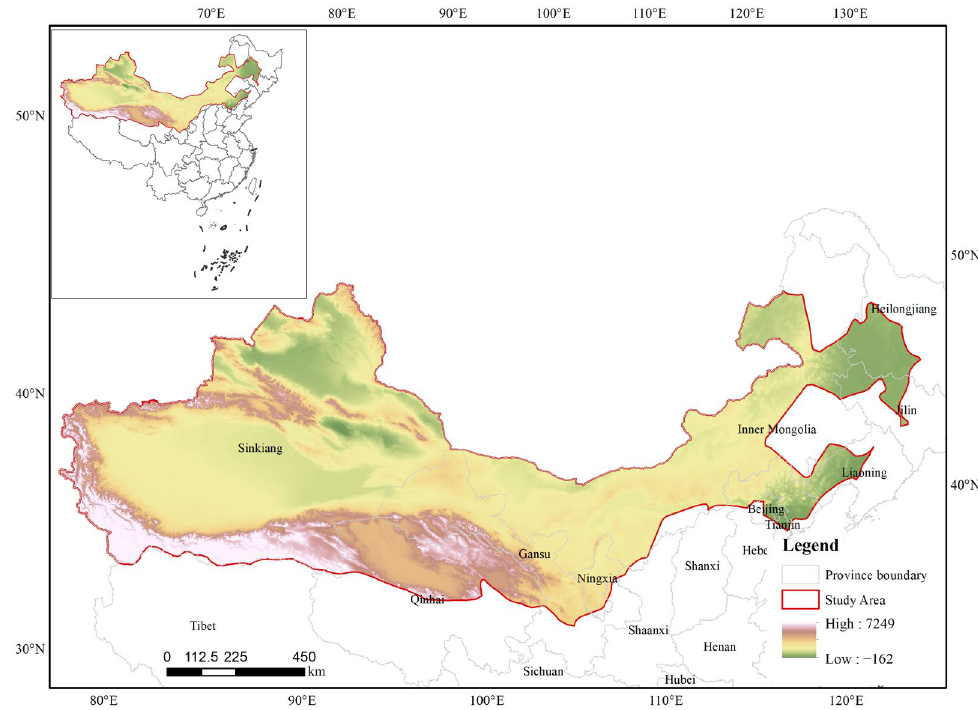
Figure 1. Location of study